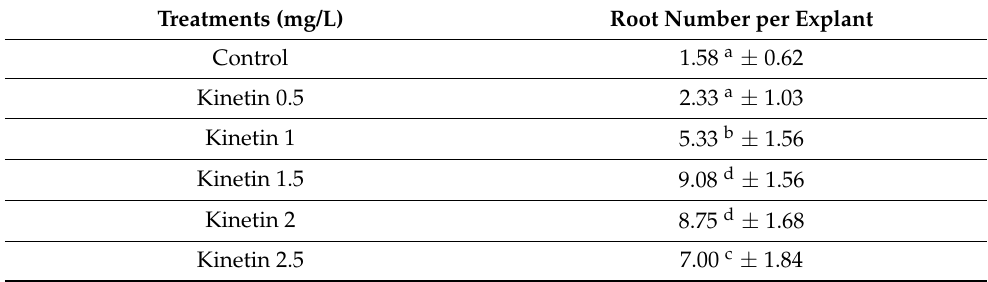
Table 2. Effect of kinetin on root